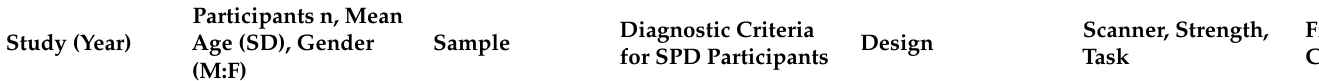
Table 2. The characteristics of the selected studies for SPD